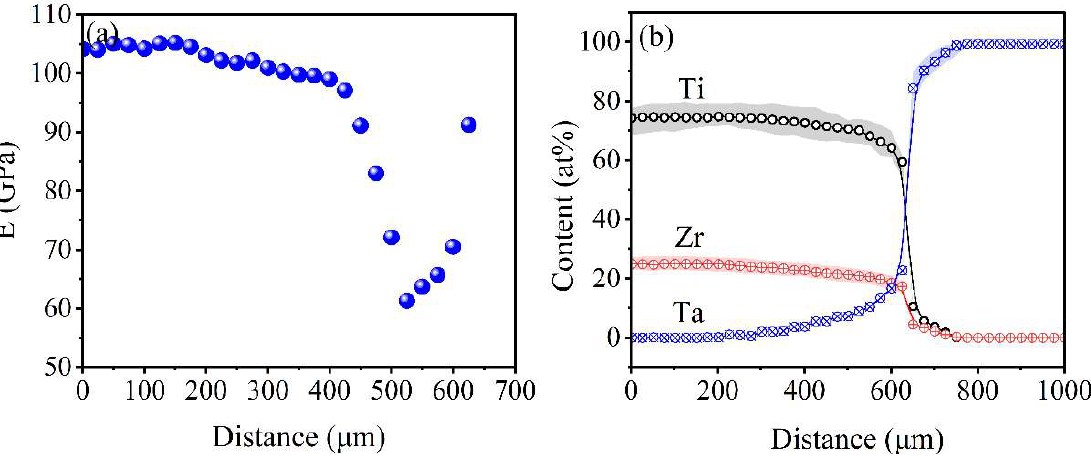
Figure 3. Variations in ( a ) modulus and ( b ) composition with distance. The shaded areas show the data ranges of the chemical composition.